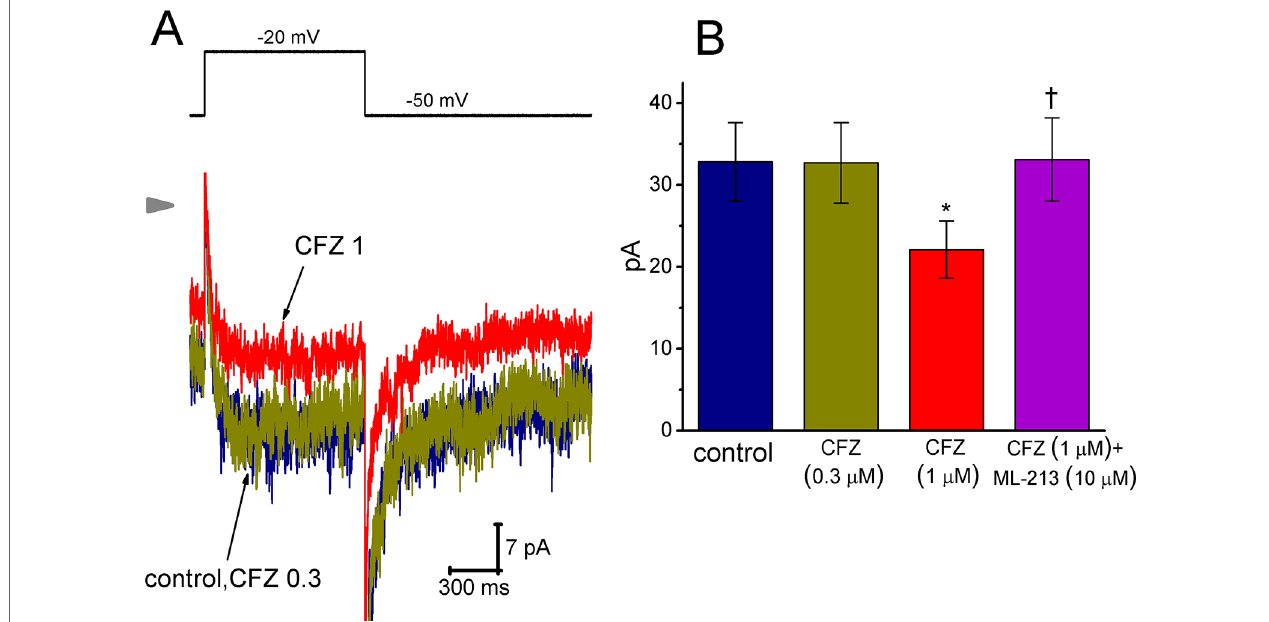
FIGURE 5 | Effect of CFZ on I K(M) in GH 3 cells. To record I K(M) , we bathed cells in high-K + , Ca 2+ -free solution and filled the recording pipette by using K + -containing solution. (A) Representative I K(M) traces in response to membrane depolarization (indicated in the upper part). CFZ 0.3:0.3 µM CFZ; CFZ 1:1 µM CFZ. Arrowhead shows the zero current level. (B) Bar graph showing the effects of CFZ and CFZ plus ML-213 on I K(M) amplitude taken from GH 3 cells (mean ± SEM; n = 8–9 for each bar). Current amplitude was measured at the end of depolarizing pulse from −50 to −20 mV. *Significantly different from control ( P < 0.05) and † significantly different from 1 µM CFZ alone group ( P <